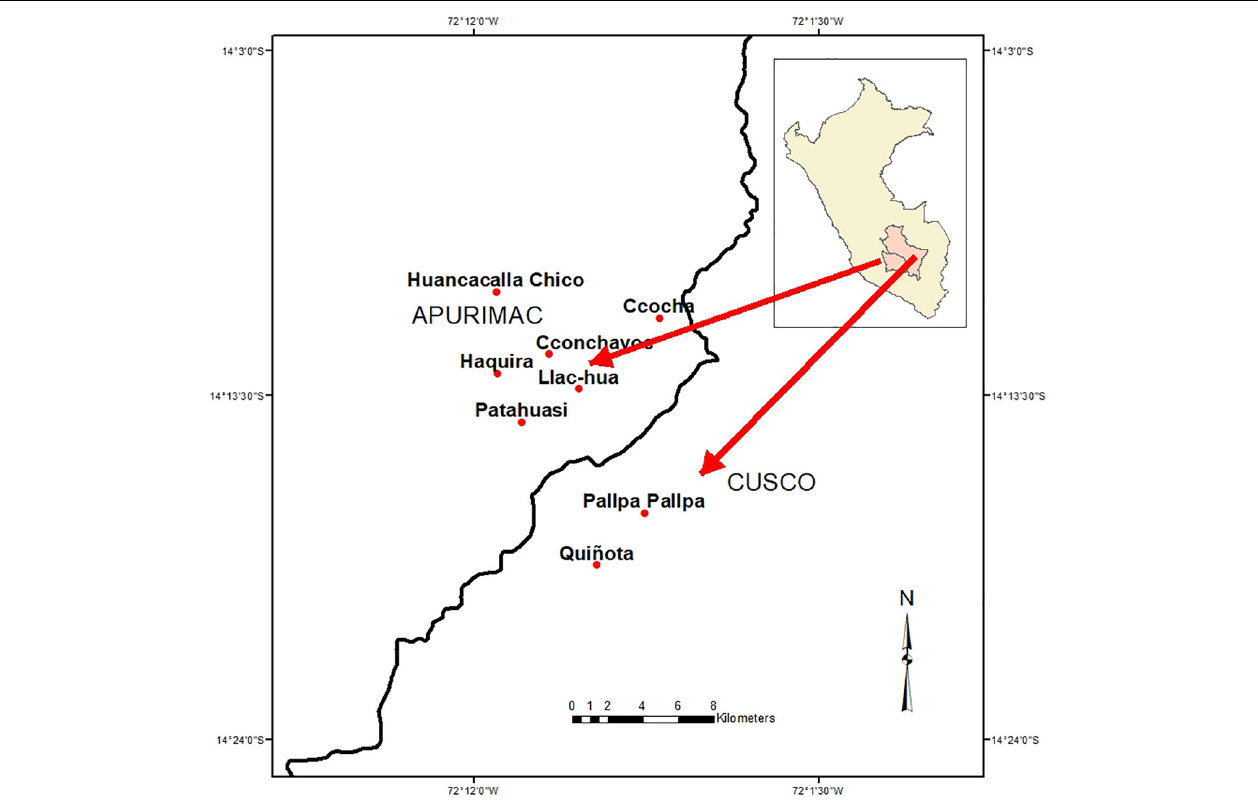
FIGURE 2 | Map of the study area in Cusco and Apurimac regions at southern Peru. Sites Quiñota and Pallpa pallpa, in Cusco, as well as in Haquira, Huancacalla Chico, Llaccua, Cconchayoc, and Patahuasi in Apurimac (red